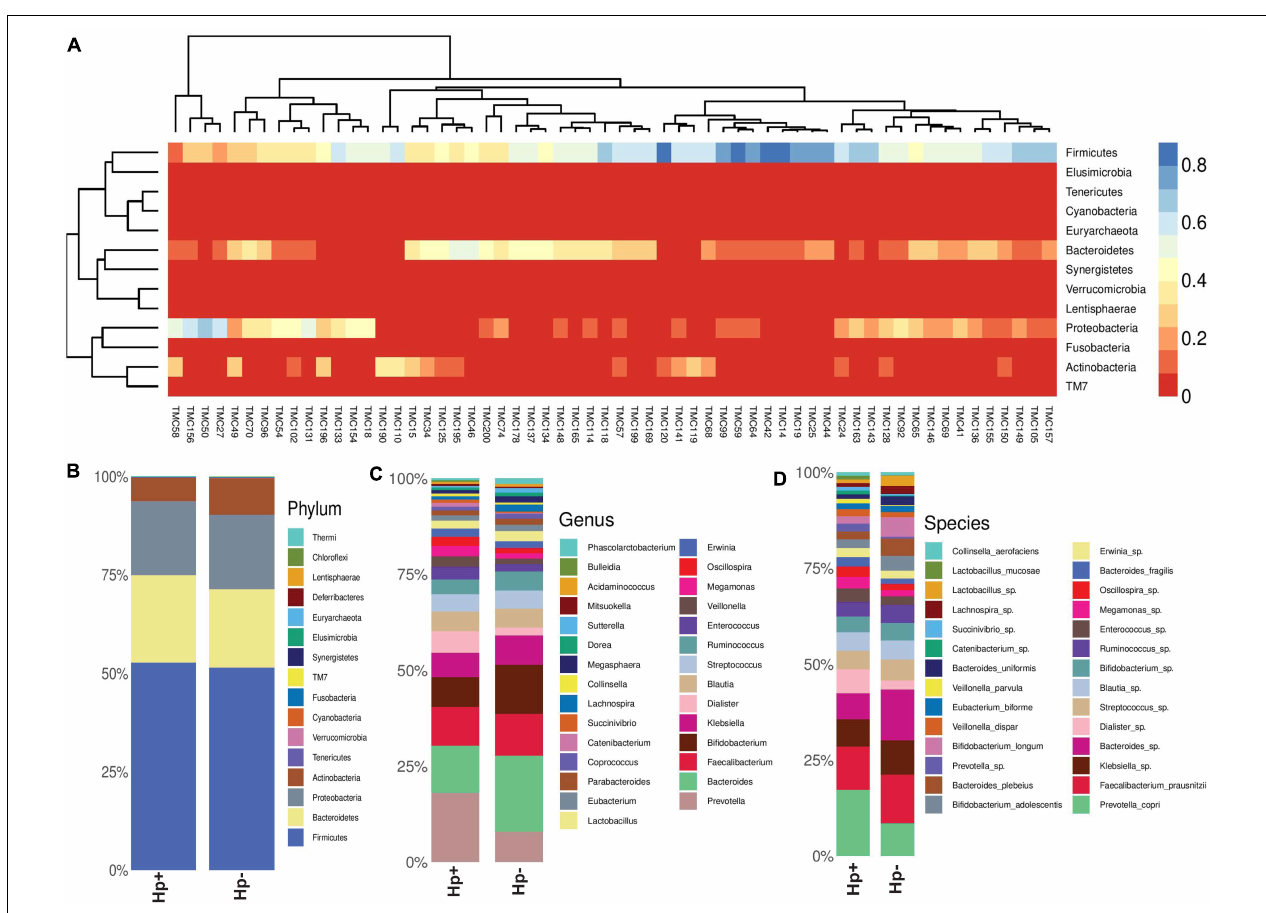
FIGURE 5 | (A) Heat map showing the relative abundances of different phyla for each sample ( N = 60). (B) Relative abundances of different phyla in gut shown in stacked column for the H. pylori + (Hp+) and the H. pylori − (Hp − ) groups. The Hp+ group has less relative abundance of the Phylum Actinobacteria. (C) Relative abundances of different genera in gut shown in stacked column for the H. pylori + (Hp+; N = 30) and the H. pylori − (Hp − ; N = 30) groups. The Hp+ group has less relative abundance of the genus Bifidobacterium . (D) Relative abundances of different bacterial species in gut shown in stacked column for the H. pylori + (Hp+; N = 30) and the H. pylori − (Hp − ; N = 30) groups. The Hp+ group has less relative abundance of the Bifidobacterium longum and B. adolescentis. The bacterial species that vary between the H. pylori + and the H. pylori − groups are B. longum (Kruskal-Wallis, p = 0.009), B. adolescentis ( p = 0.03), B. bividum ( p = 0.004), B. plebeius ( p = 0.05), B. uniformis ( p = 0.04), and P. copri ( p =